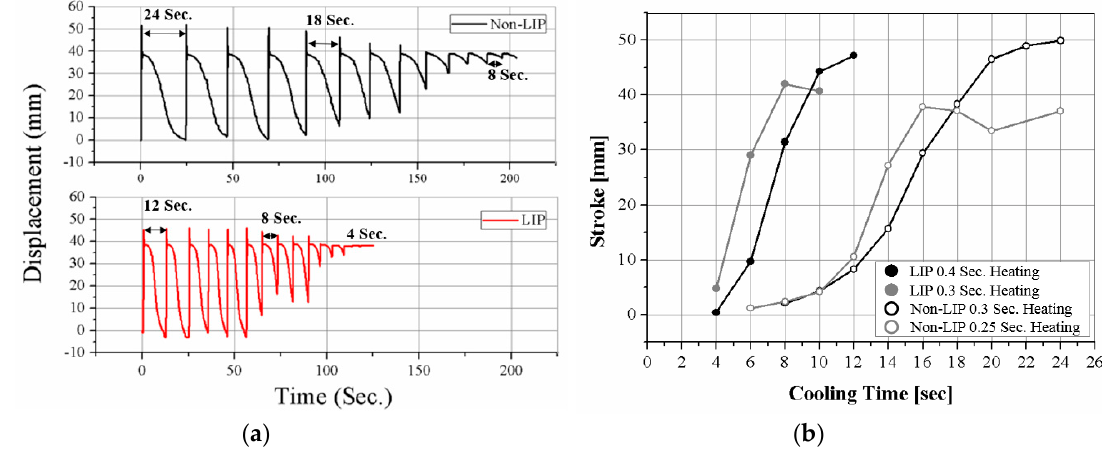
Figure 9. Cyclic actuation results for various cooling times: ( a ) time–displacement responses for decreasing cooling time; ( b ) actuation stroke results depending on cooling time with two different heating times; insufficient heating time (gray lines), optimal heating time (black lines).